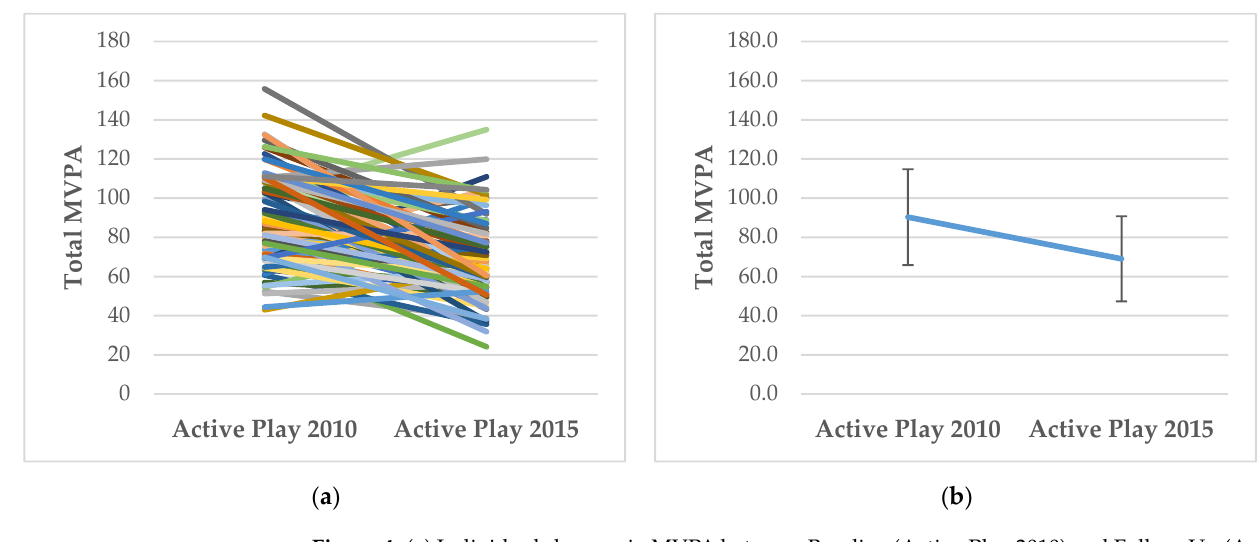
Figure 4. ( a ) Individual changes in MVPA between Baseline (Active Play 2010) and Follow-Up (Active Play 2015); ( b ) Mean (±SD) changes in MVPA between Baseline (Active Play 2010) and Follow-Up (Active Play 2015). Table 3. Means, standard deviations and summary of repeated measures analysis for FMS competency scores and MVPA among boys and